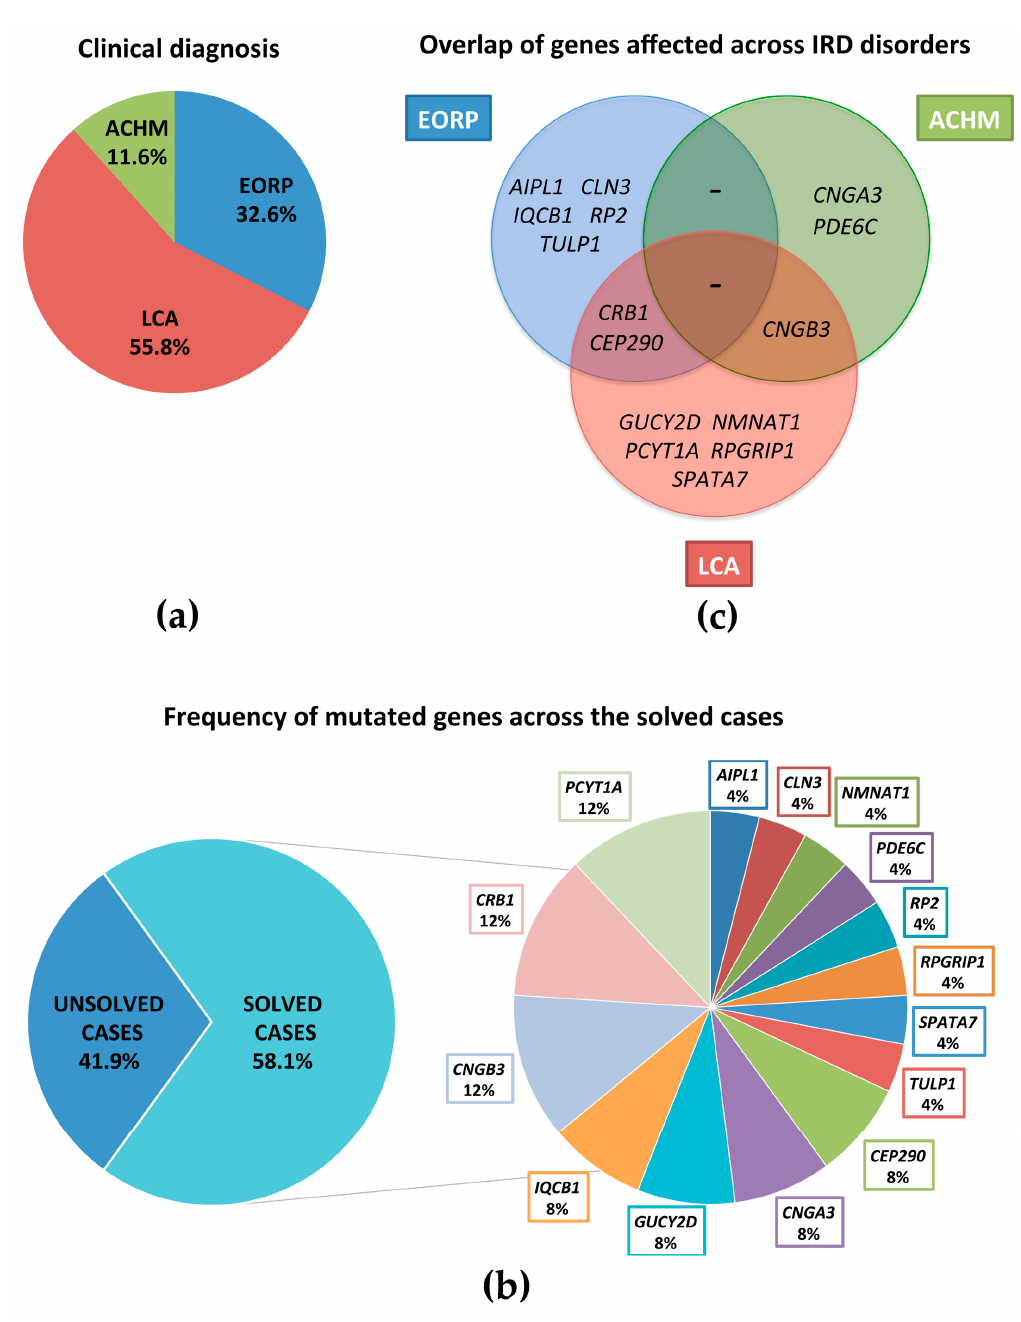
Figure 1. Distribution of clinical diagnosis and mutated genes across the 43 pediatric patients. ( a ) Distribution of clinical diagnosis across the 43 patients with LCA, EORP, and ACHM; ( b ) Frequency of the mutated genes across the solved cases of severe inherited retinal dystrophies (IRD) reported in this study; ( c ) Venn diagram showing the genetic heterogeneity of retinal dystrophies and an overlap between the genetic causes of different IRDs.